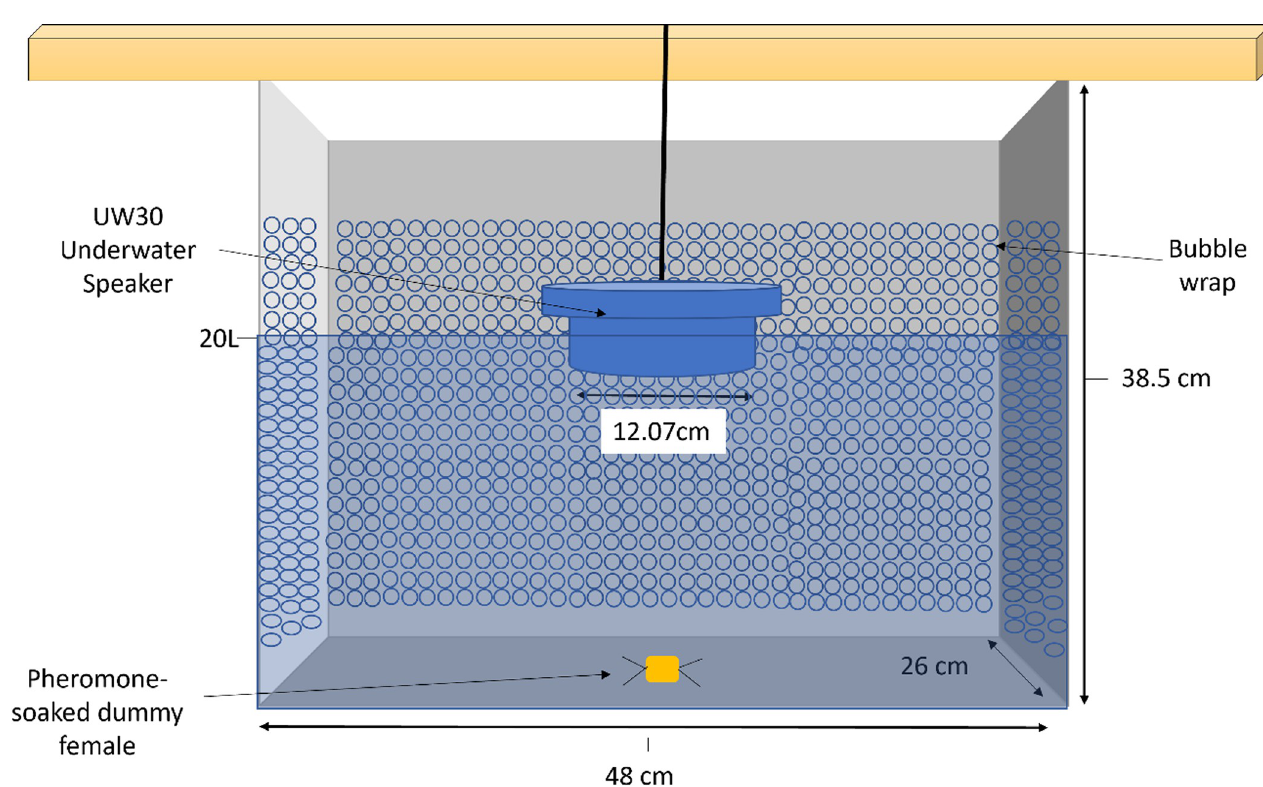
Fig 2. Experimental tank setup with 1) bubble wrap lining three sides of the interior of the tank to reduce sound reverberation, 2) hanging underwater speaker so just speaker is submerged under the water line from a horizontal wooden plank, and 3) pheromone-soaked sponge made to resemble a female